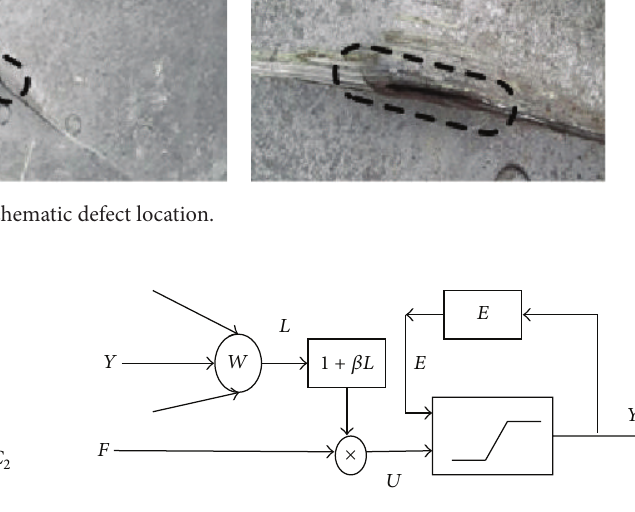
Figure 8: The equivalent circuit of neuron. Figure 9: The model of PCNN